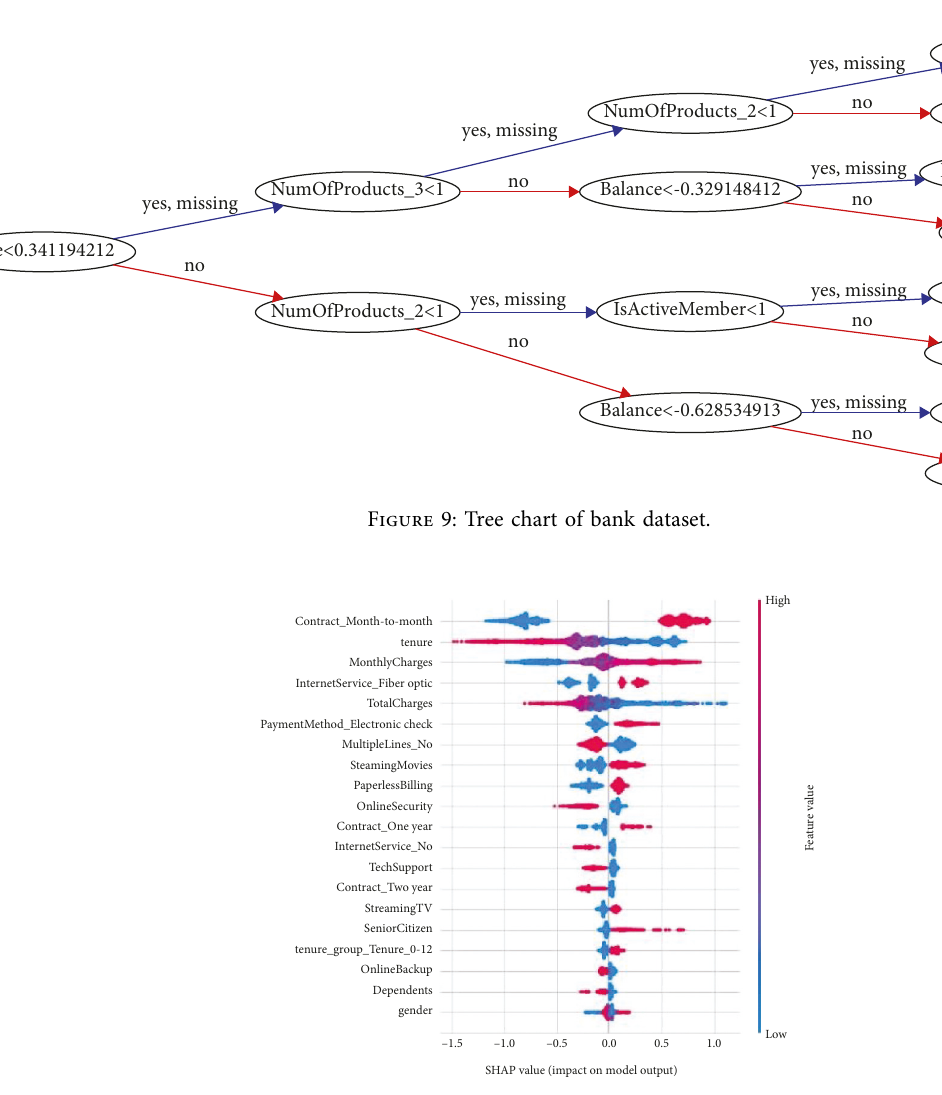
Figure 10: SHAP summary of IBM dataset.